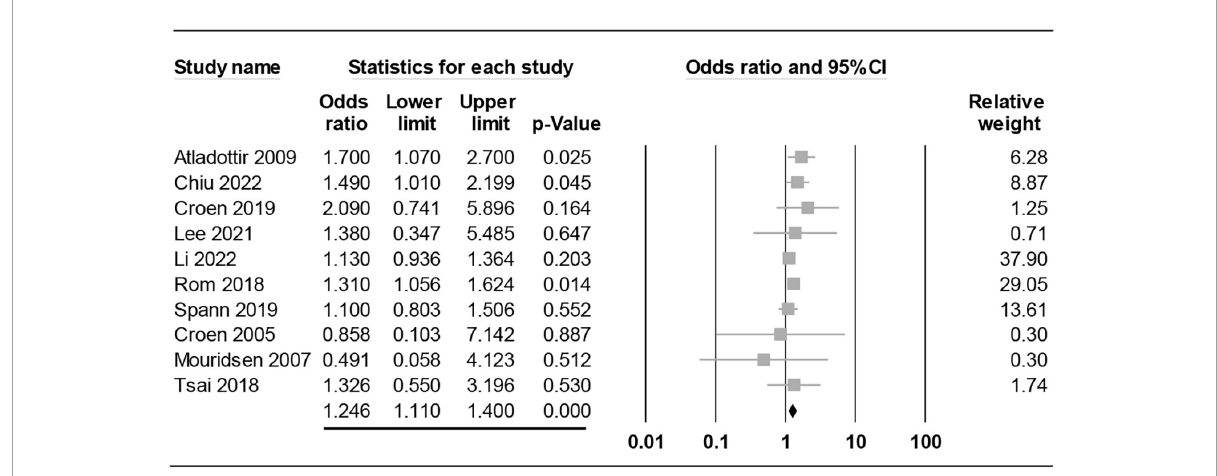
FIGURE2 Forest plot showing association of maternal rheumatoid arthritis (RA) with risk of offspring autism spectrum disorder (ASD) regardless of the timing of maternal RA diagnosis. CI, confidence